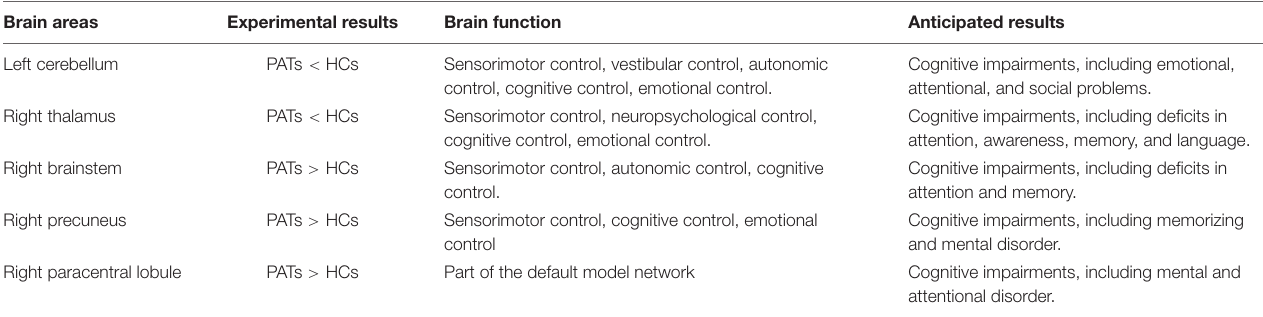
TABLE 4 | Brain areas alternations and anticipated